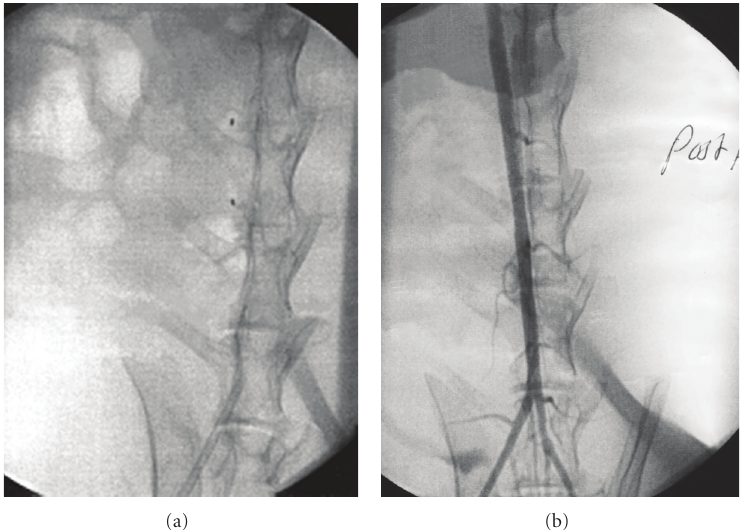
Figure 1: Angioplasty of abdominal aorta. (a) The balloon location is assessed by the markers in the balloon. (b) Post-PTA-angiography, di ff erent rabbit than in (a), showing the aortic bifurcation.